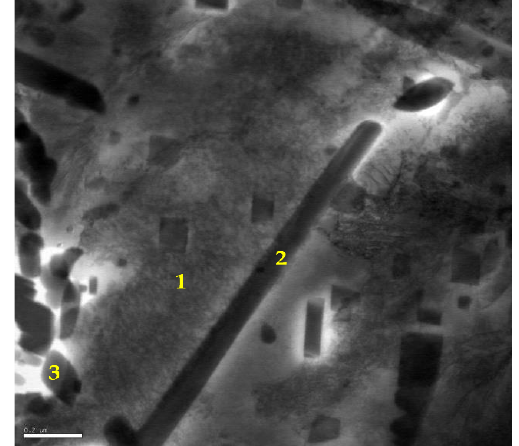
Figure 4. Optical micrographs of the conventionally heat-treated alloys: ( a ) 2124; ( b ) 2127; ( c ) 2427; ( d ) 2827; ( e ) 2927.